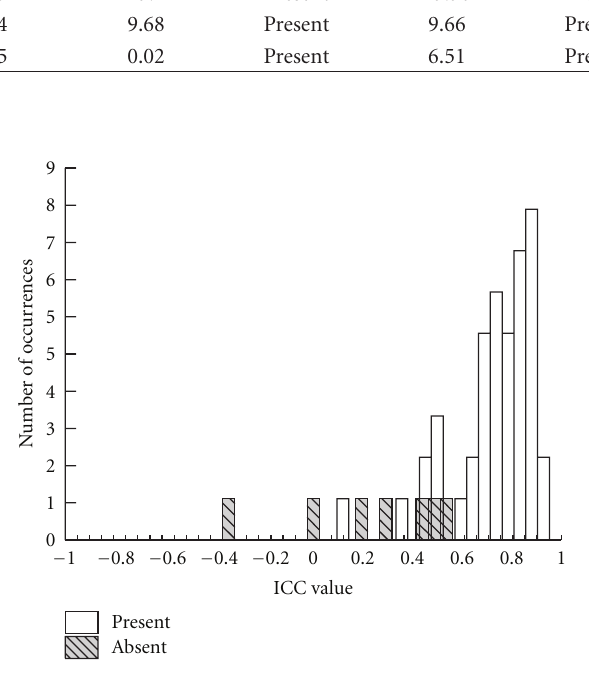
Figure 1: Histogram of ICC values for CAEPs waveforms judged to be present and absent.